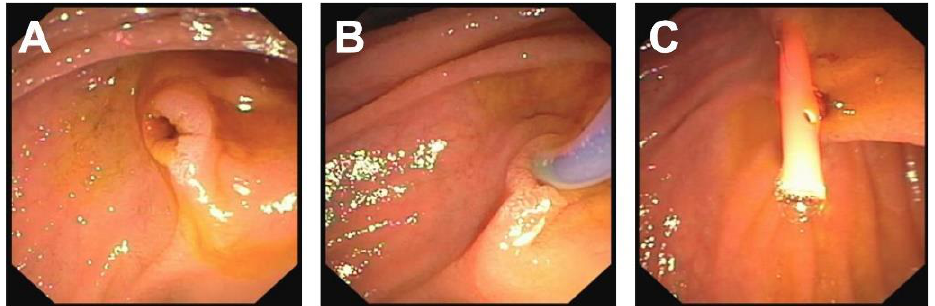
Figure 4. Transgastric endosonography showing a retention at the site of rupture ( A ). Transgastric placement of a pigtail drain ( B ).